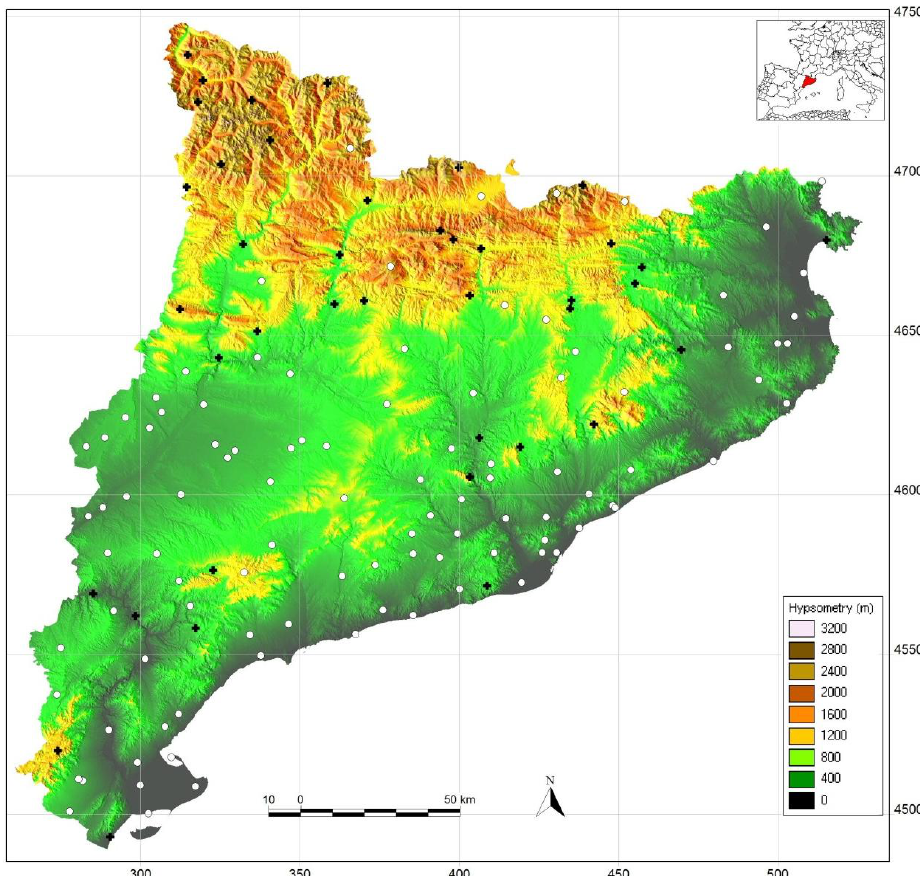
Fig. 1. Distribution of meteorological stations selected to validate the DSSF product depending on the terrain class: flat (white dots) and hilly (black crosses). Coordinates in UTM-31N and divided by 1000.